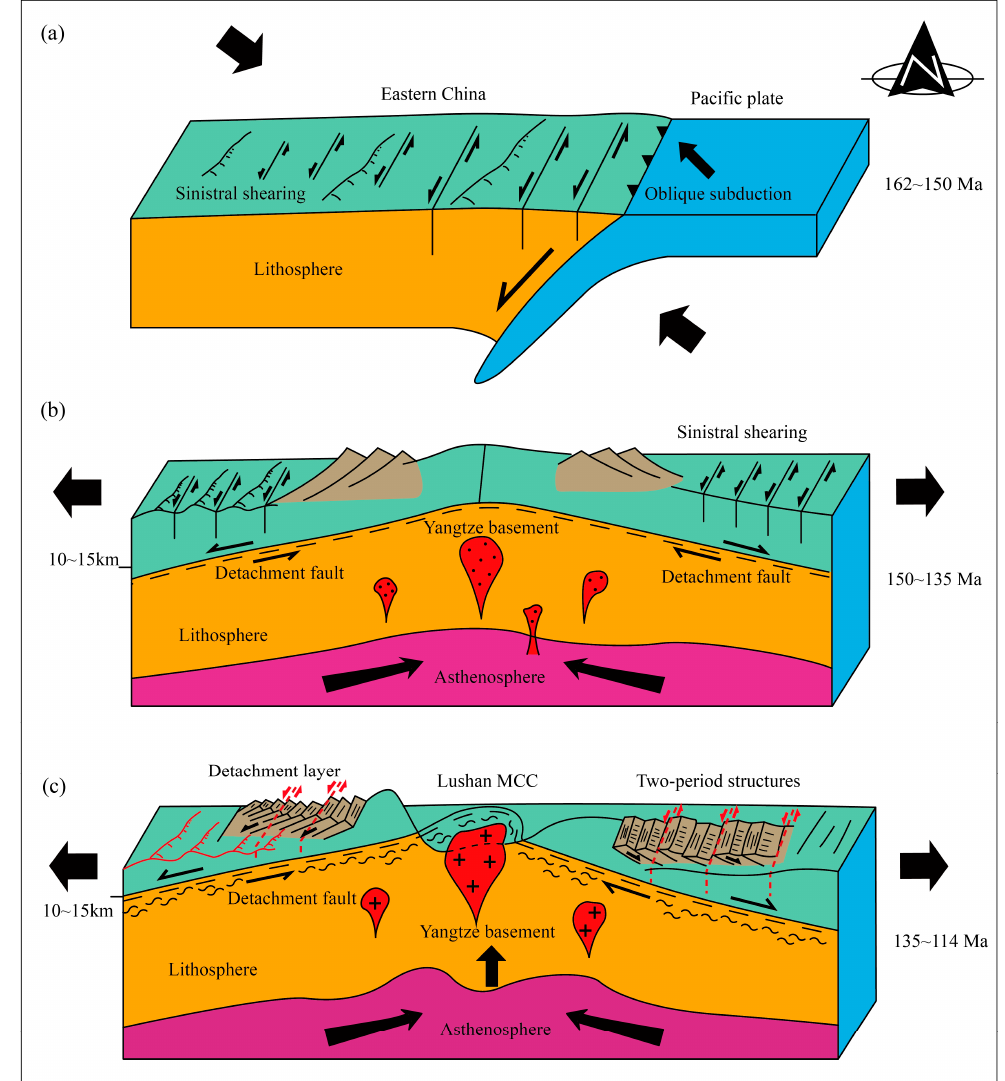
Figure 13. Schematic diagram showing the formation and evolution of two-period structures for the Lushan area. ( a ) Oblique subduction of the Pacific plate resulted in compressional stress field with formation of sinistral shear structures; ( b ) the compressional stress transformed into extensional stress under lithospheric thinning with the formation of extensional structures; ( c ) extension detachment and magmation led to the formation and uplift of the LSED.